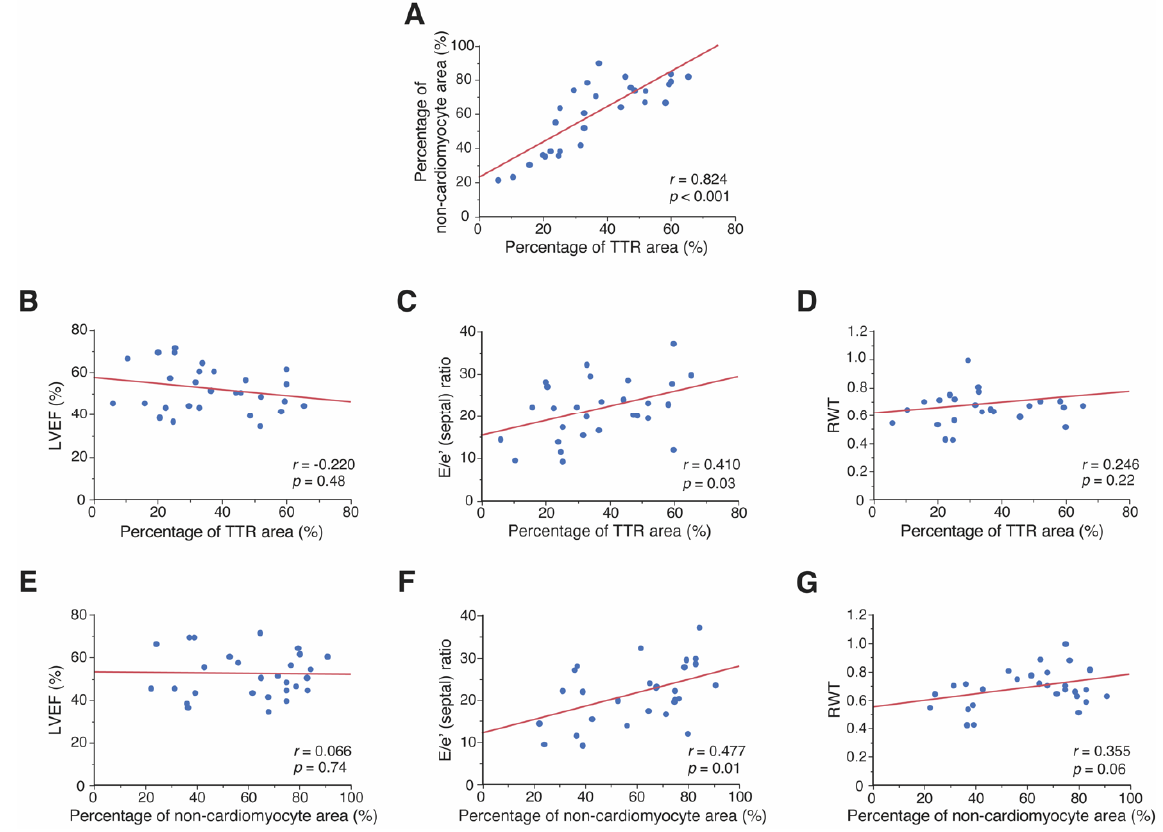
Figure 2. Pathological features and their association with echocardiographic parameters in patients with ATTR-CM. Relationship between the percentage of TTR area and ( A ) percentage of non-cardiomyocyte area, ( B ) LVEF, ( C ) E/e’ (septal) ratio, and ( D ) RWT. Relationship between the portion of non-cardiomyocyte area and ( E ) LVEF, ( F ) E/e’ (septal) ratio, and ( G ) RWT. ATTR-CM, transthyretin amyloid cardiomyopathy; E/e’ (septal) ratio, early transmitral filling velocity (E)/peak early diastolic velocity of the septal mitral annulus (e’) ratio; LVEF, left ventricular ejection fraction; RWT, relative wall thickness; TTR, transthyretin.